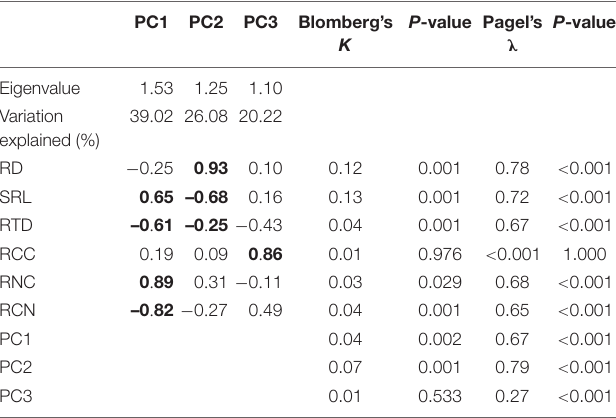
TABLE 2 | Phylogenetic principal component analysis (pPCA) results and phylogenetic signals of the six root traits for all species.